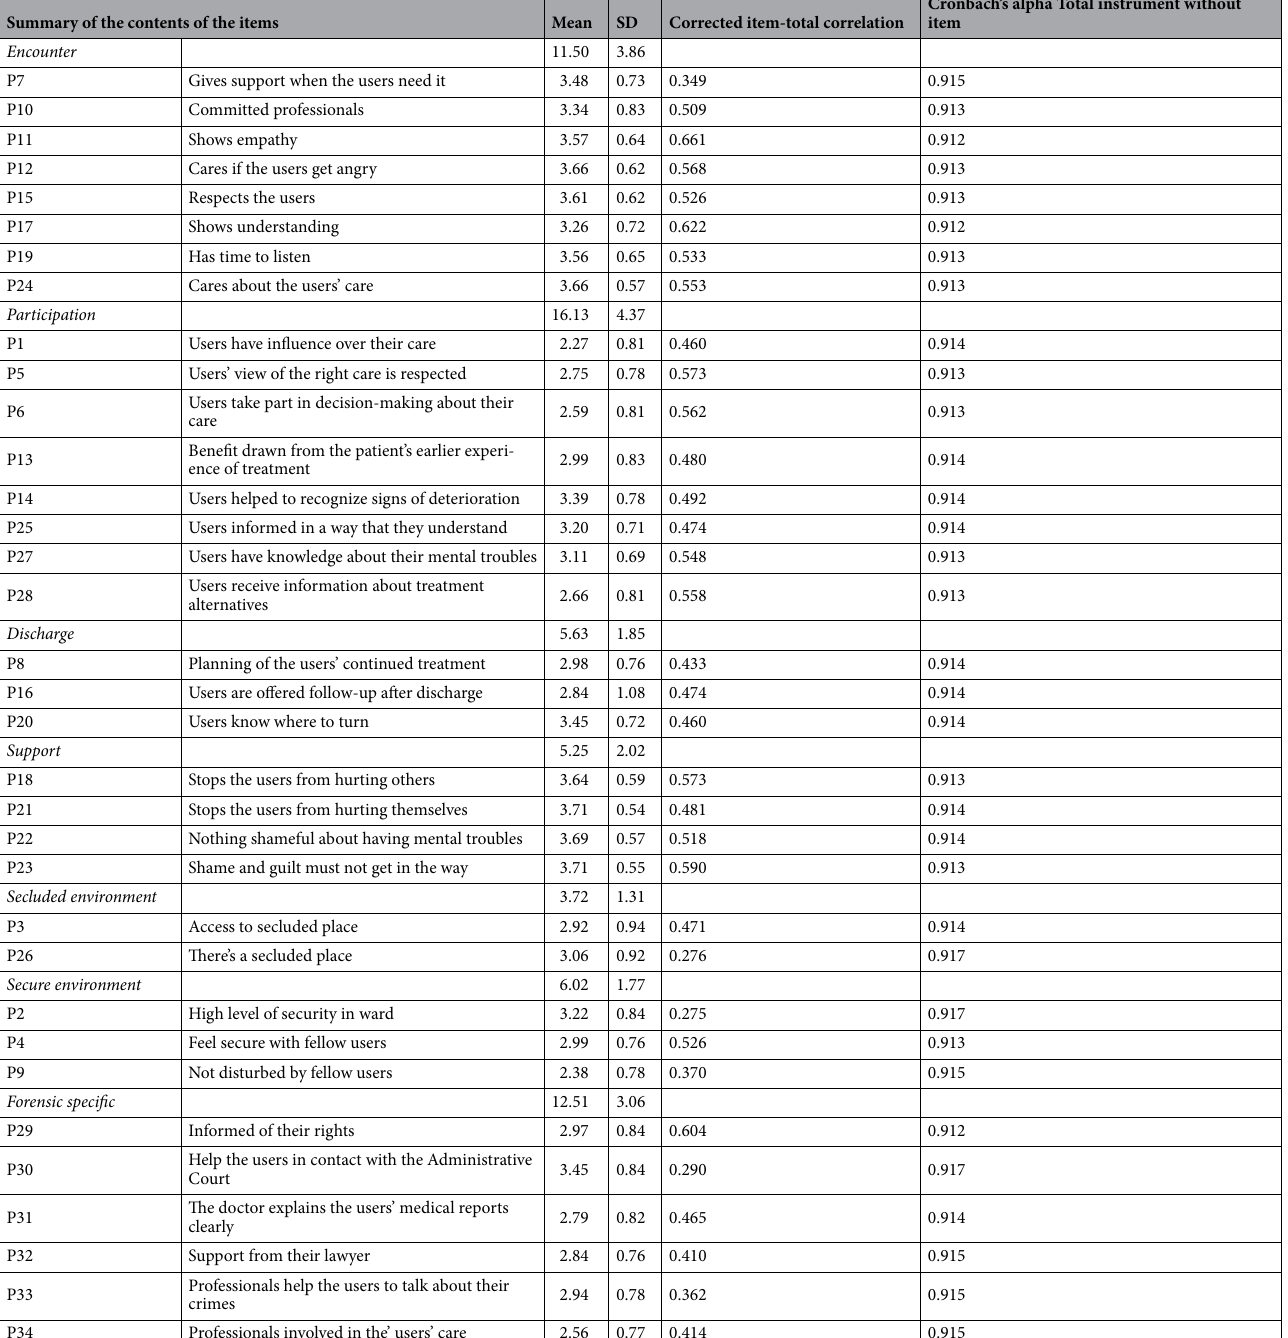
Table 3. Descriptive Statistics of the Items of the QPC-FIPS Scale and Cronbach’s alpha. SD Standard